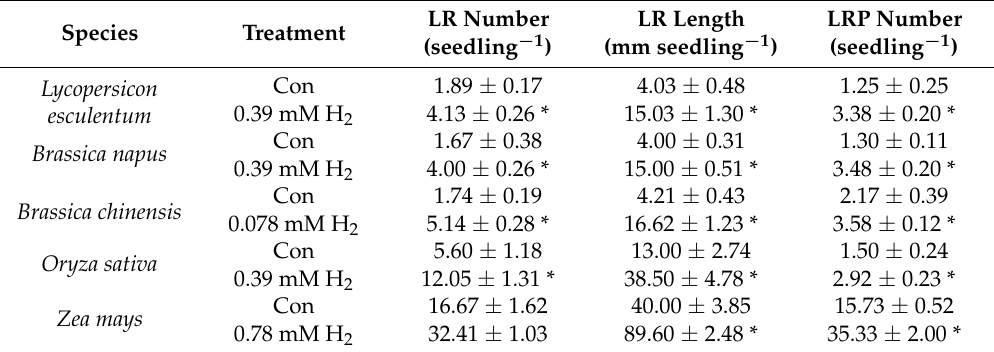
Table 1. Exogenous H 2 -induced lateral root formation is